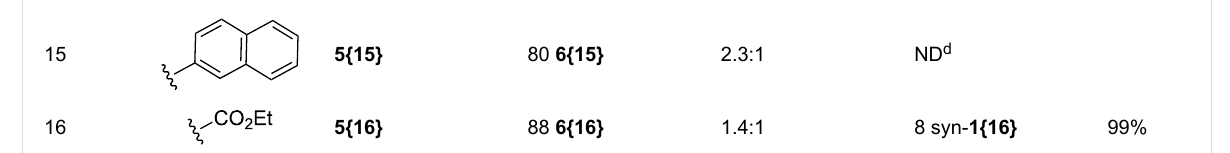
Table 1: Library of N -tosyltetrahydro- β -carbolinepyrrolines 7{1–7} .